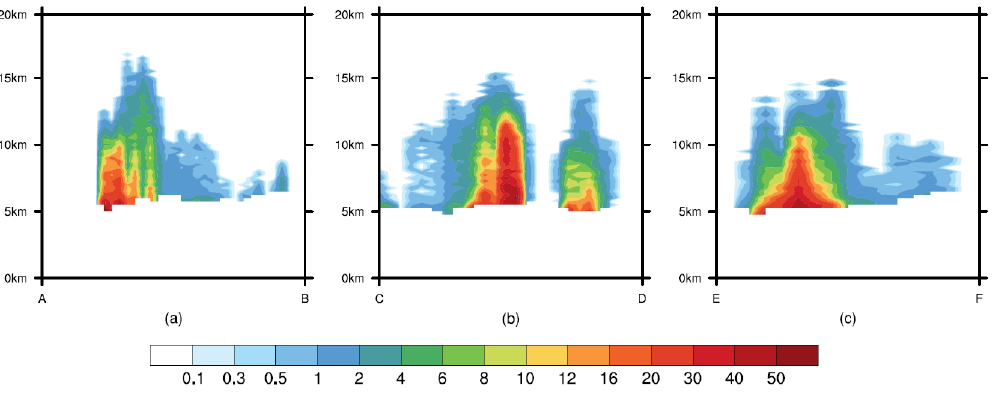
Figure 4. Vertical cross-sections of the rainfall (units: mm·h −1 ). The ( a ), ( b ), and ( c ) graphs represent the A–B, C–D, and E–F paths, respectively, from Figure 3a.